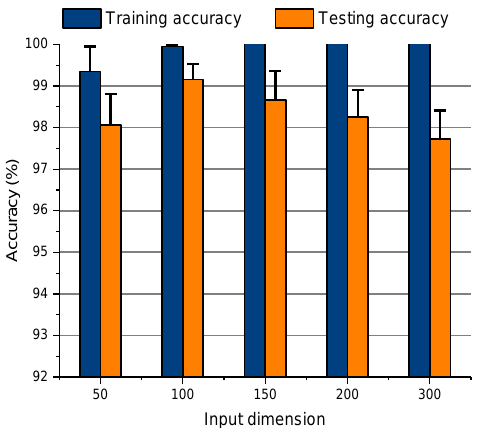
Figure 6. Classification results of sparse filtering of various input dimensions.